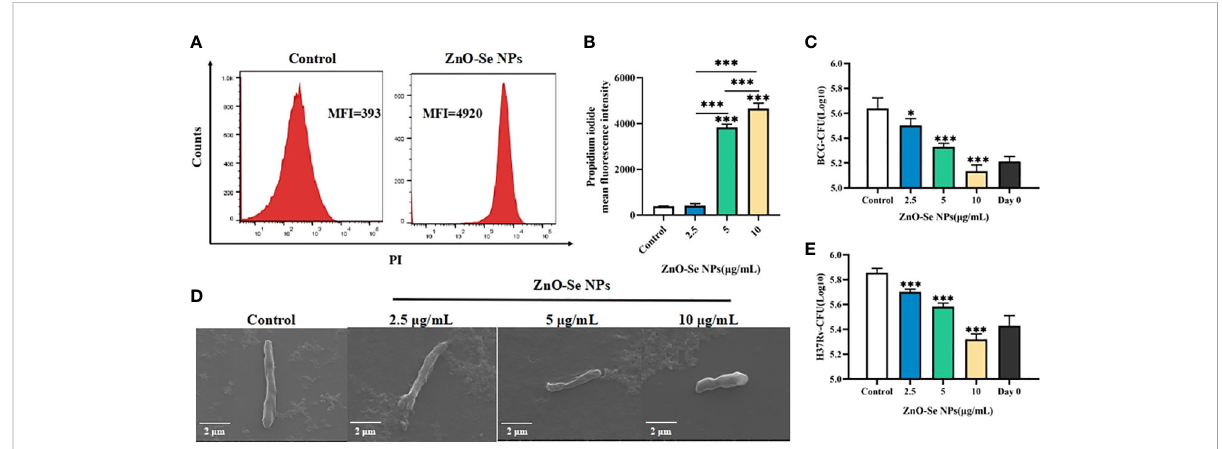
FIGURE 2 Killing/inhibition effects of ZnO-Se NPs against Mtb. (A) Typical fl ow cytometry analysis of PI signals for BCG before and after 10 m g/mL ZnO-Se NPs treatment. (B) Statistical results of PI signals for BCG before and after ZnO-Se NPs treatment, n=3, ***p<0.001. (C) Effects of ZnO-Se NPs on the growth of extracellular BCG, n=3, *p<0.05, ***p<0.001. (D) SEM images of BCG before and after ZnO-Se NPs treatment, scale bar: 2 m m. (E) Effects of ZnO-Se NPs on the growth of extracellular H37Rv, n=3,